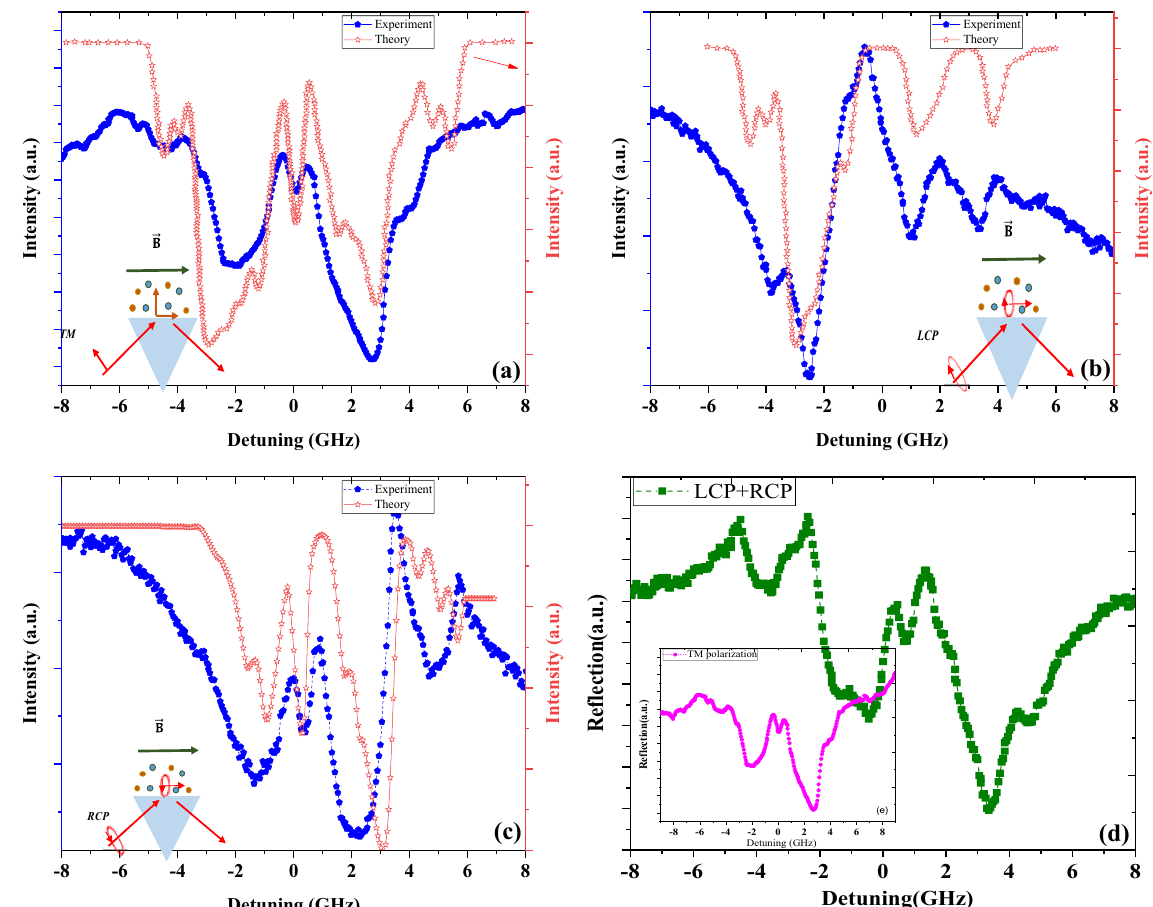
Figure 3. Comparison of experimental (top) and simulation (bottom) results for ( a ) absorption of evanescent waves formed by p-polarized incidence light, ( b ) absorption of evanescent waves formed by left circularly polarized light, ( c ) absorption of evanescent waves formed by right circularly polarized light, ( d ) summation of normalized LCP and RCP experimental data of ( b , d ), inset shows experimental data shown in (a), brought for